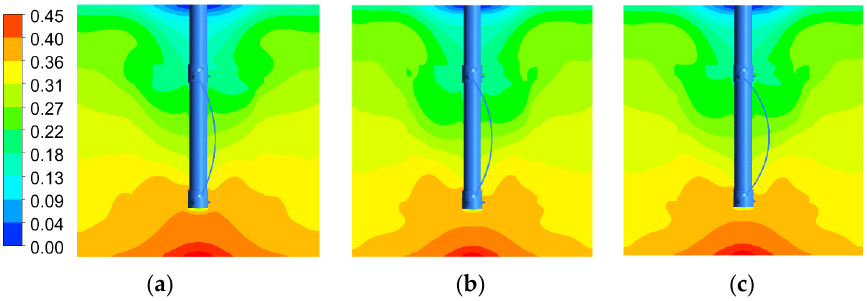
Figure 18. Contour plots of solid distribution for DRFTBI with different connection strap lengths.